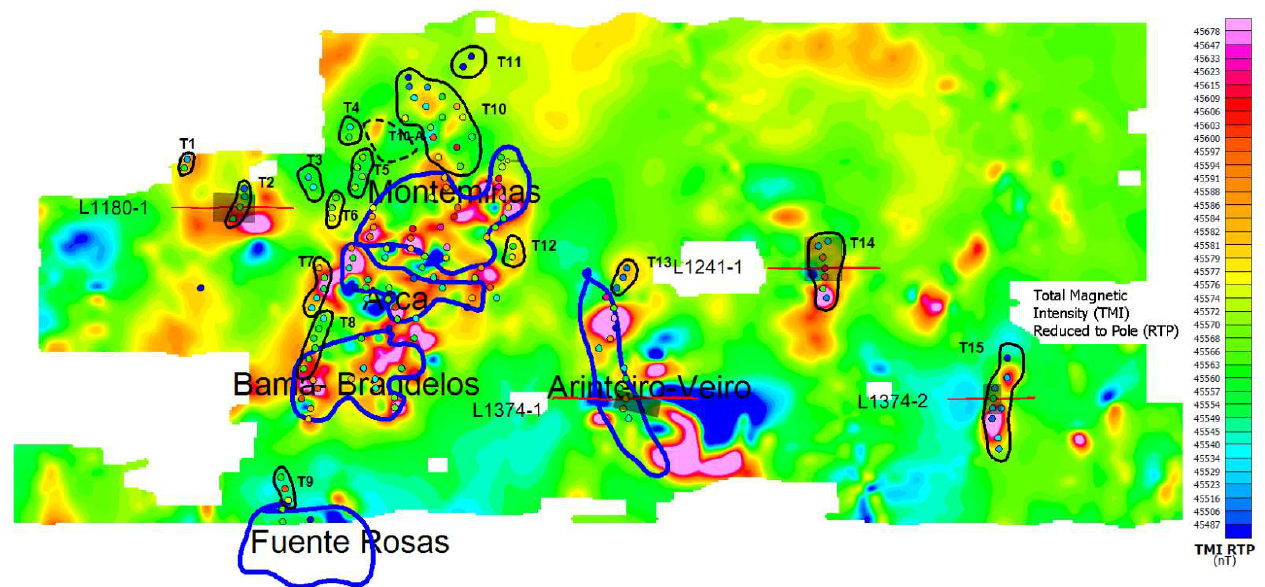
Figure 6. VTEM EM channel SFz25 (coloured background), known ore bodies (blue outlines). VTEM anomaly pick coloured symbols, with values > 20 Siemens, permitting the definition of additional areas of interest identified as targets T1 to T15 (black outlines). The cultural anomalies were not delineated.